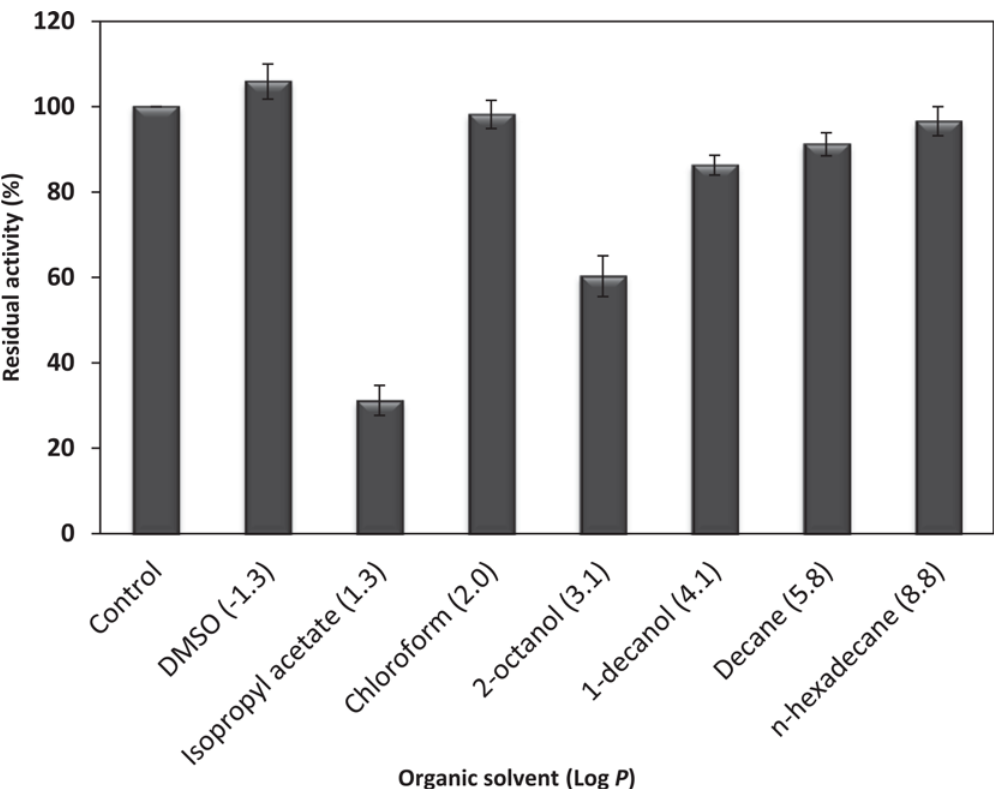
Fig 4. Effect of organic solvents on stability of the recombinant HZ lipase. 25% (v/v) of organic solvents were added to the intracellular enzyme and incubated at 50°C with 200 rpm shaking for 30 min. SD is indicated as error bars. When the error bar cannot be seen, the deviation is less than the size of the